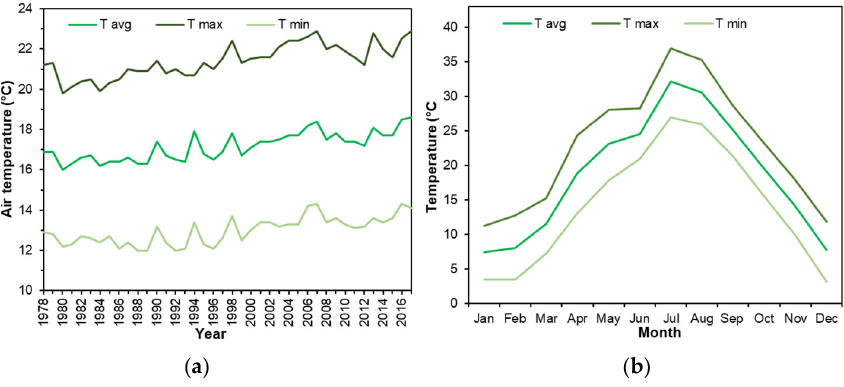
Figure 3. ( a ) Meteorological condition of Hangzhou city (1978–2017). ( b ) Weather condition of Hangzhou in the year of 2017. (Note: T avg: average air temperature, T max: average maximum air temperature, T min: average minimum air temperature).